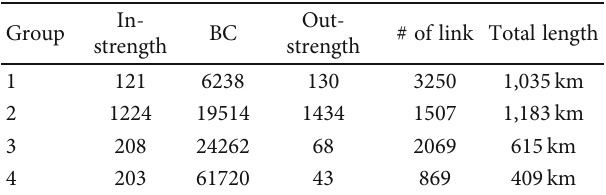
Figure 5: The optimal number of clusters with PAM clustering method. Table 1: Results of link